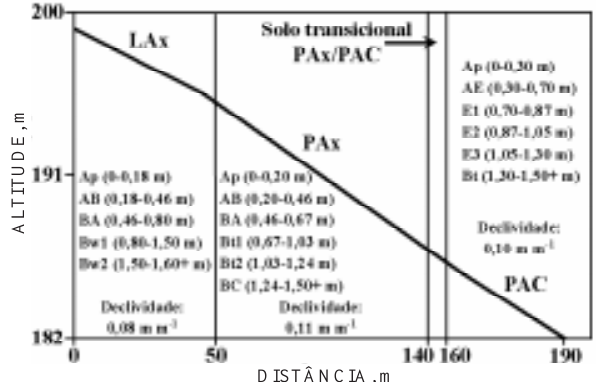
Figura 2. Altitude e posição dos solos Latossolo Amarelo argissólico (LAx), Argissolo Amarelo (PAx), solo transicional PAx/PAC e Argissolo Acinzentado (PAC), estudados em uma toposseqüência em tabuleiro do estado da